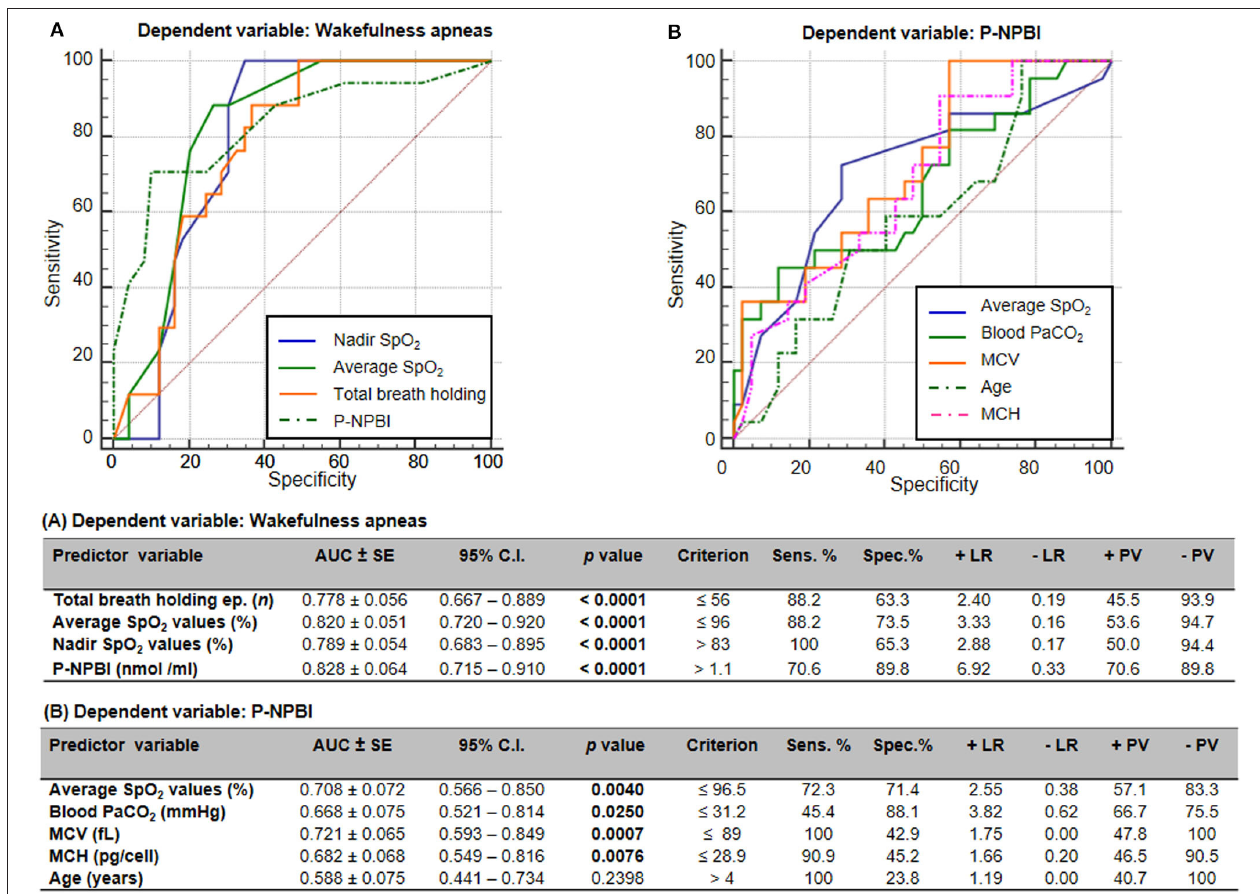
FIGURE 6 | Receiver operating characteristic (ROC) curves analysis for (A) wakefulness apneas and (B) P-NPBI as classifying variables. AUC, area under the curve; SE, standard error; Sens, sensitivity; Spec, specificity; + LR, positive likelihood ratio; –LR, negative likelihood ratio; + PV, positive predictive value; –PV, negative predictive value; SpO 2 , peripheral oxygen saturation; P-NPBI, plasma non-protein-bound iron; PaCO 2 , partial arterial pressure of carbon dioxide; MCV, mean corpuscular volume; MCH, mean cell hemoglobin. Bold characters indicate statistically significant